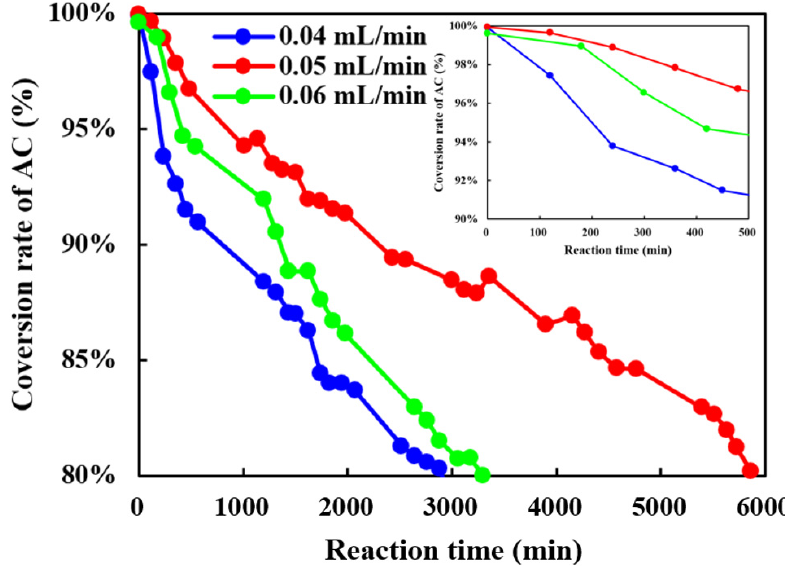
Figure 4. The influence of the volume flowrate (VF) on the continuous acylation of